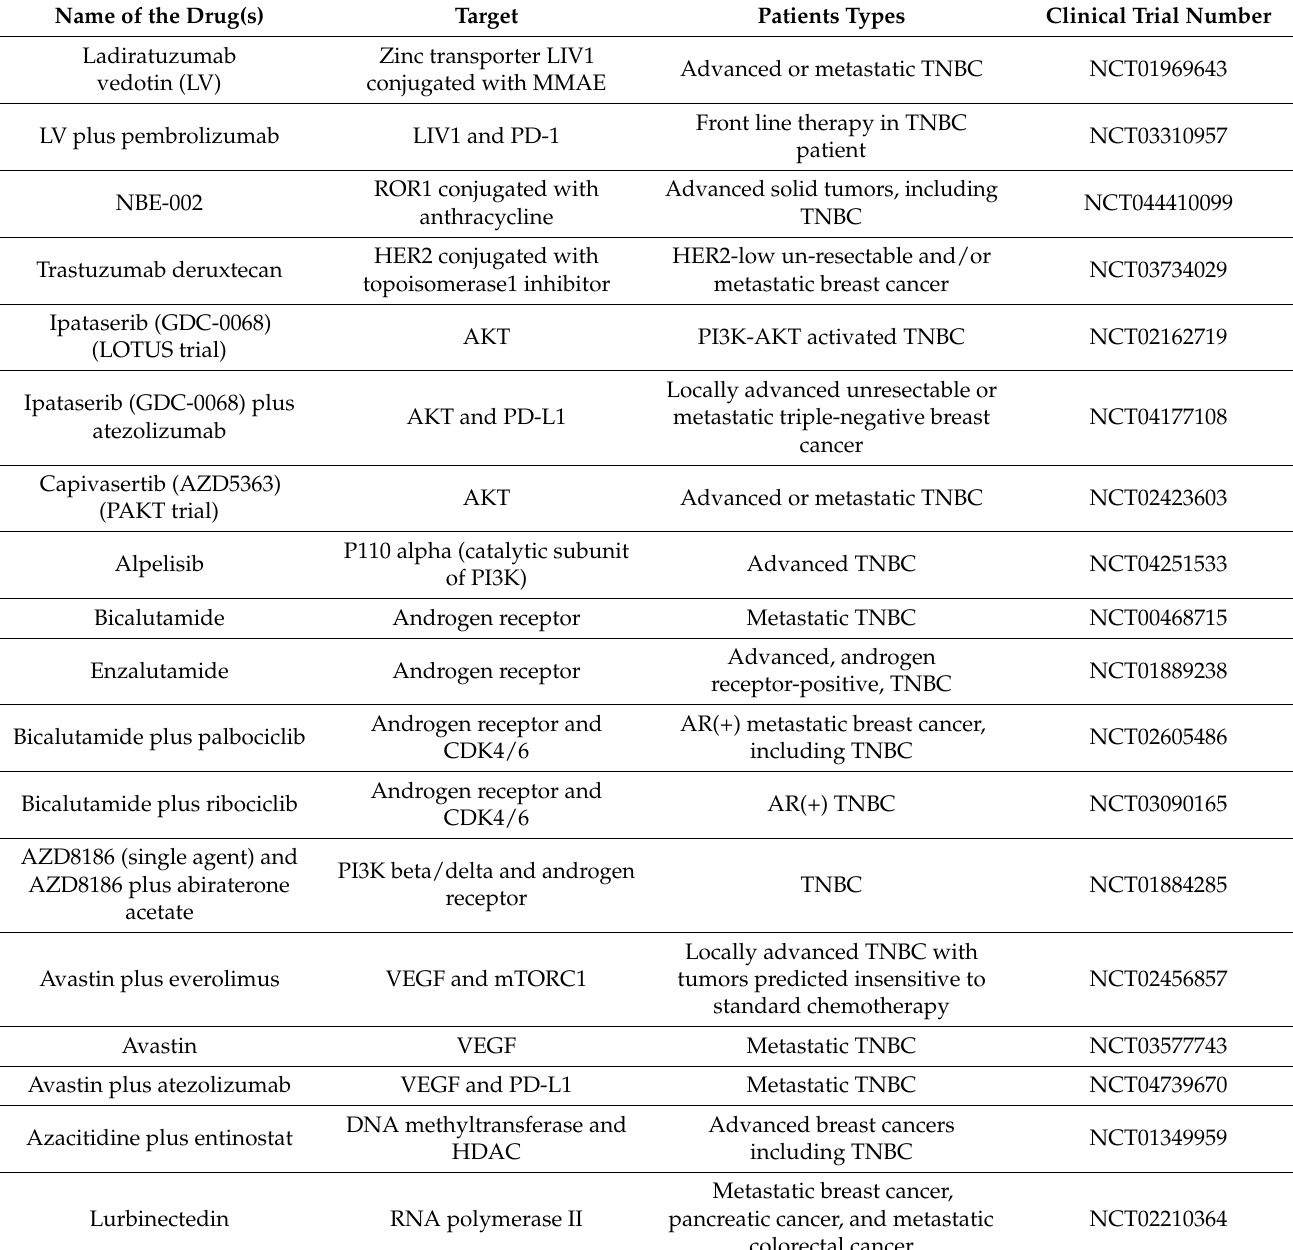
Table 1. Promising treatment options with drugs that need FDA